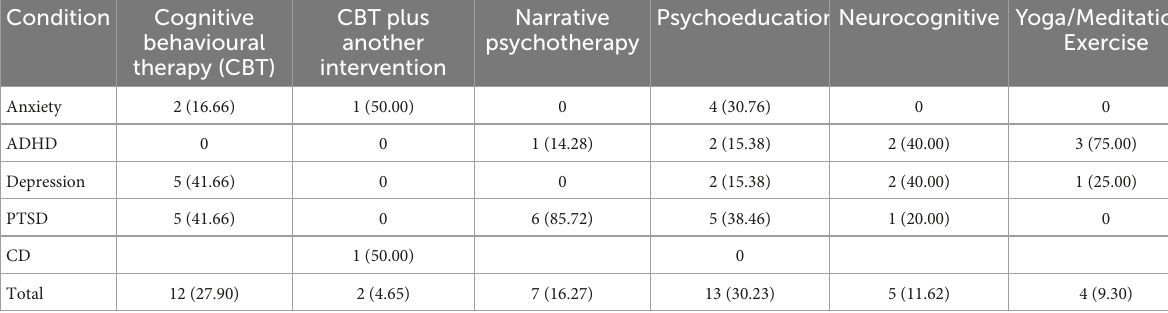
TABLE 4 Interventions investigated per condition.